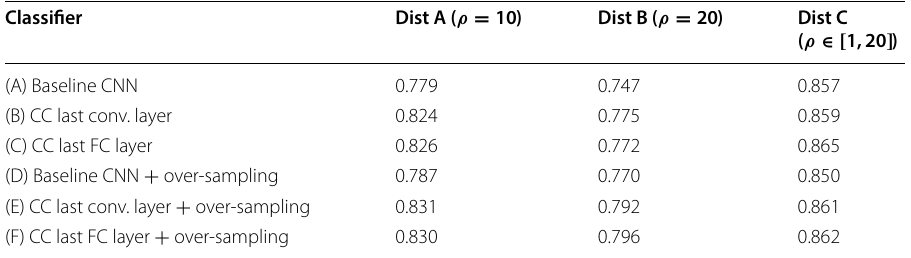
Table 11 Category centers with CIFAR-10 data (AP)